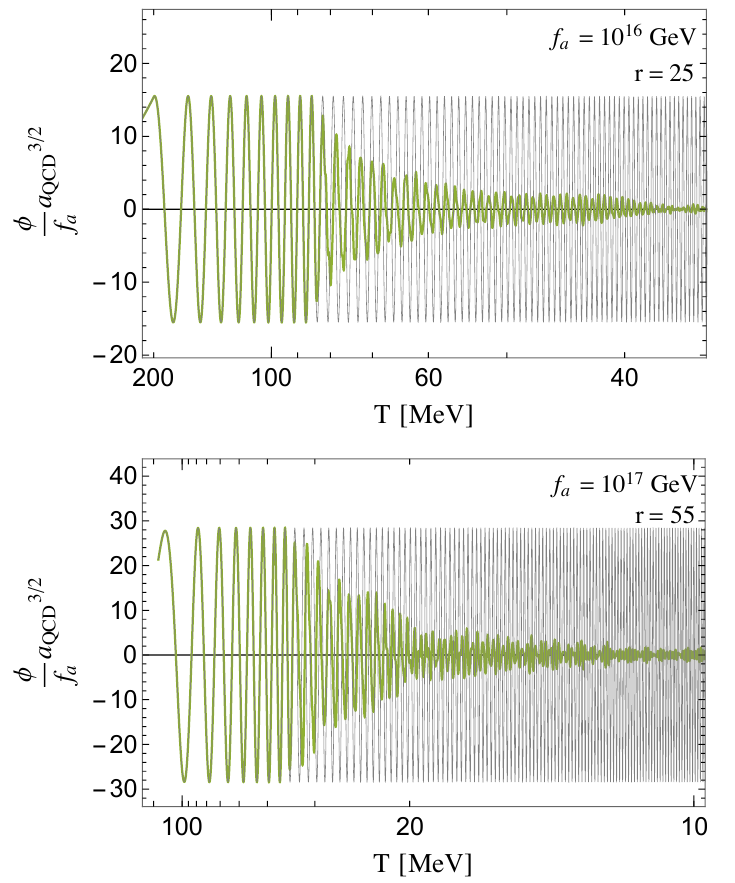
Figure 3 . The decay of the comoving axion amplitude (green) as a function of temperature due to particle production for two example values of f a and r , compared with the axion amplitude in the absence of our mechanism (gray). We normalize the scale factor a QCD ( T ) (cid:17) a ( T ) misalignment was chosen to be (cid:18) i =